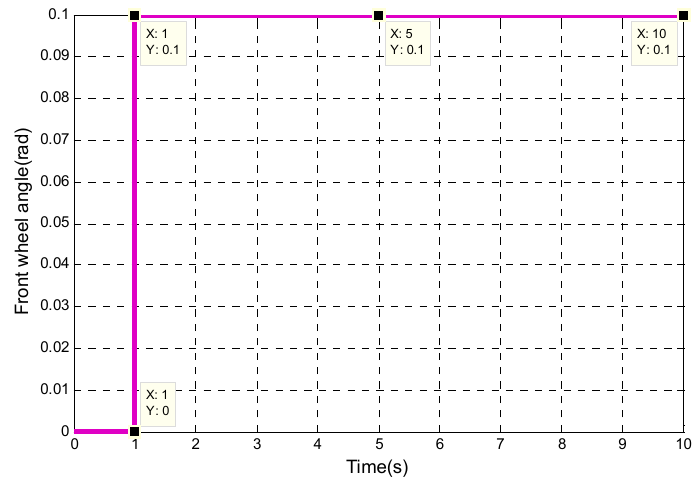
Figure 15. The front wheel angle step input.